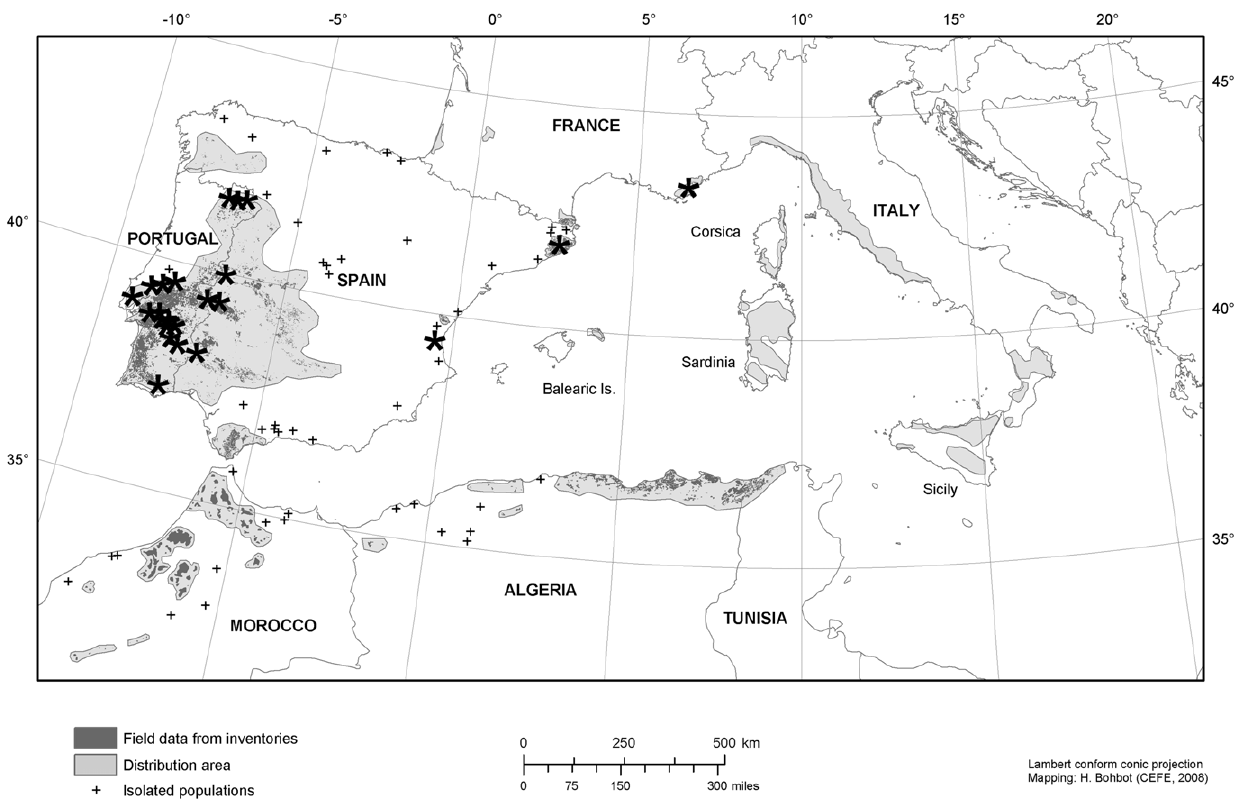
Figure 1. Distribution of Q.suber and location of the 22 study sites. General distribution of Q. suber in the Mediterranean Basin (in grey; reproduced from Pausas, Pereira & Aronson 2009 with permission from Island Press, Washington, DC) and location of the 22 study sites (black stars).